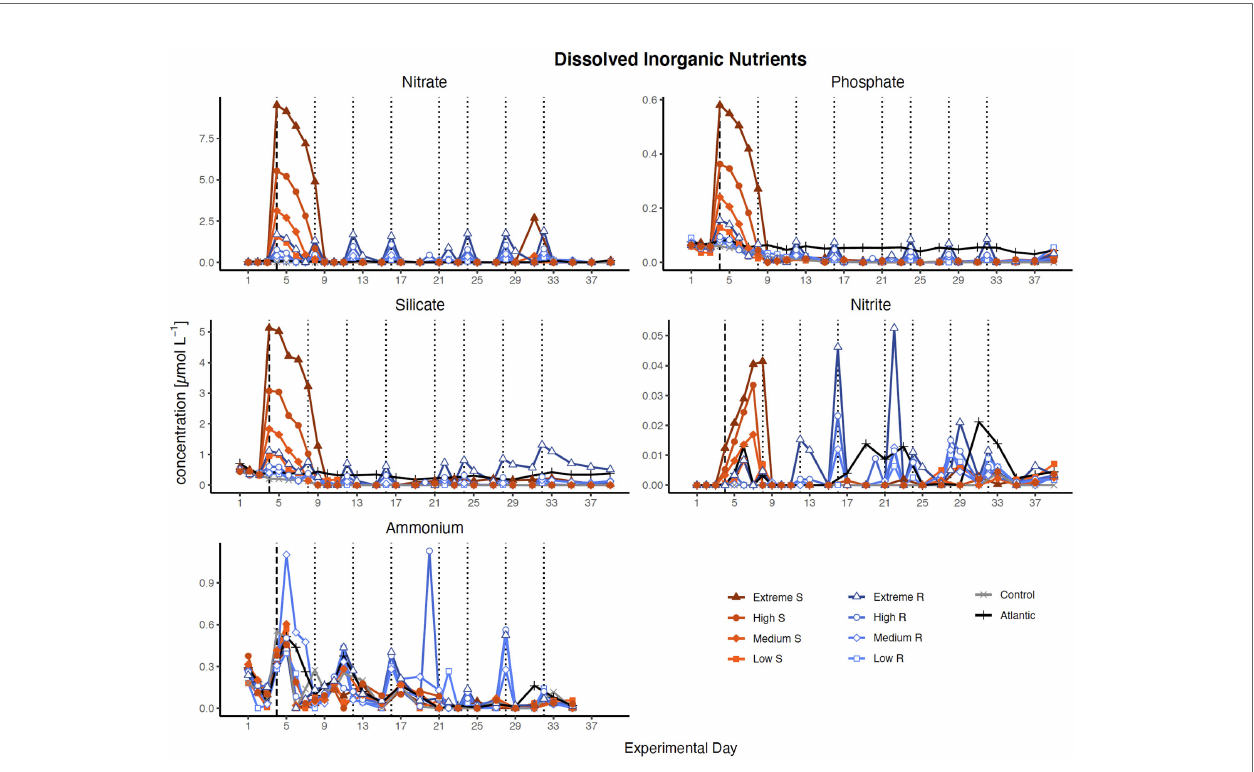
FIGURE 3 | Inorganic nutrient concentration over the course of the study. Dotted lines represent DW additions, dashed line marks the single DW addition to singular treatments. S, singular, R, recurring treatment. Atlantic refers to samples taken from the water surrounding the mesocosm fi